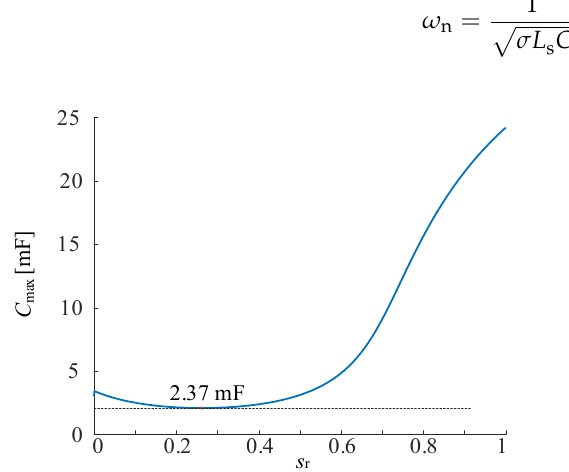
Figure 6. The relationship curve between C max and s r .